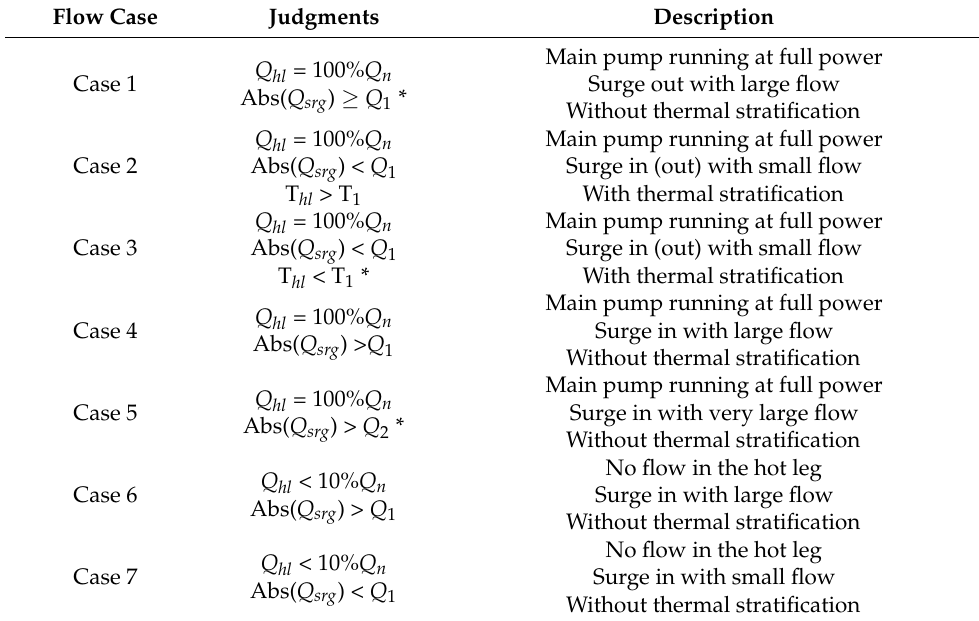
Table 1. Typical flow cases of the pressurizer surge